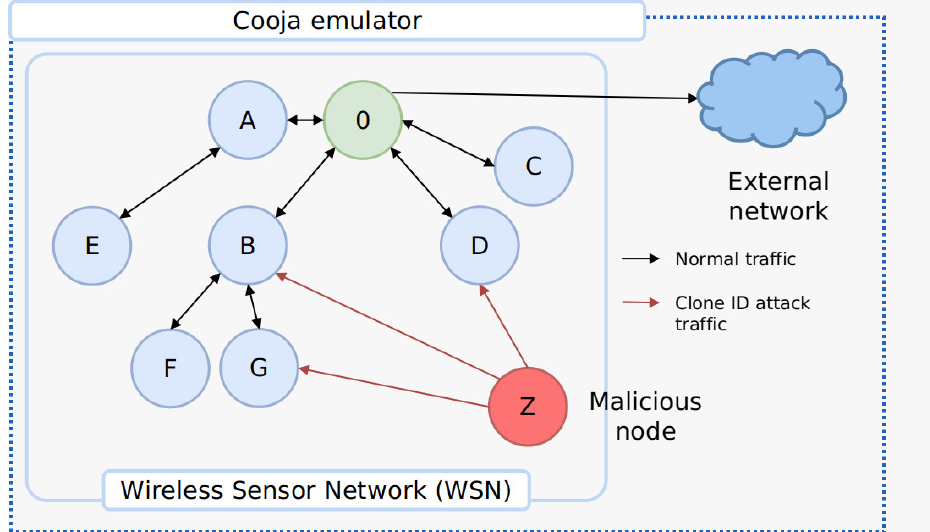
Figure 6. IoT virtual environment to simulate the Clone ID